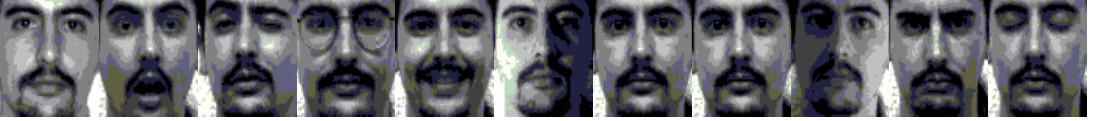
Figure 7. Sample face images of the YALE face database.